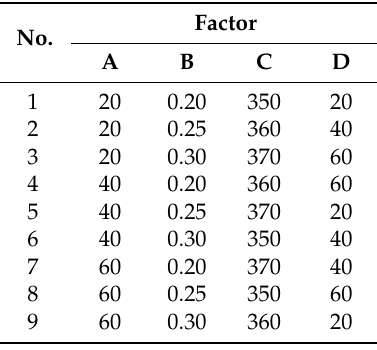
Table 2. L9 orthogonal array design for PEEK FDM.